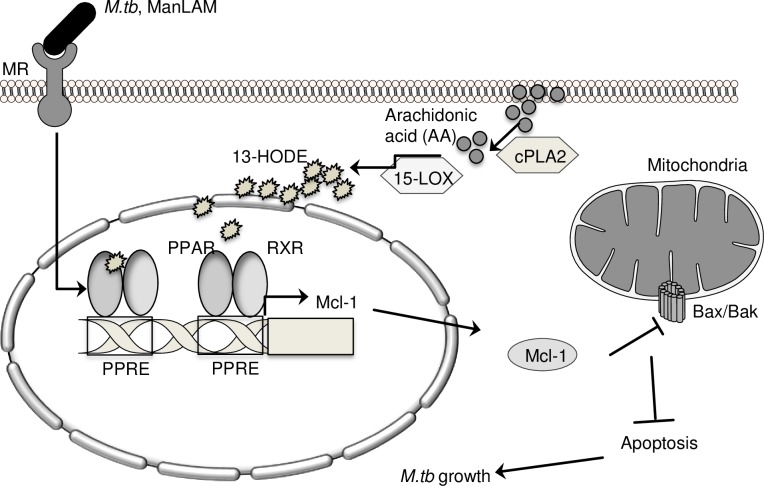
Model.In human macrophages, M.tb induces Mcl-1 expression through PPARγ, which requires 15-LOX, cPLA2, and the mannose receptor (MR) [4]. 15-LOX and PPARγ, through regulation of Mcl-1, contribute to M.tb’s ability to limit apoptosis and grow in human macrophages.